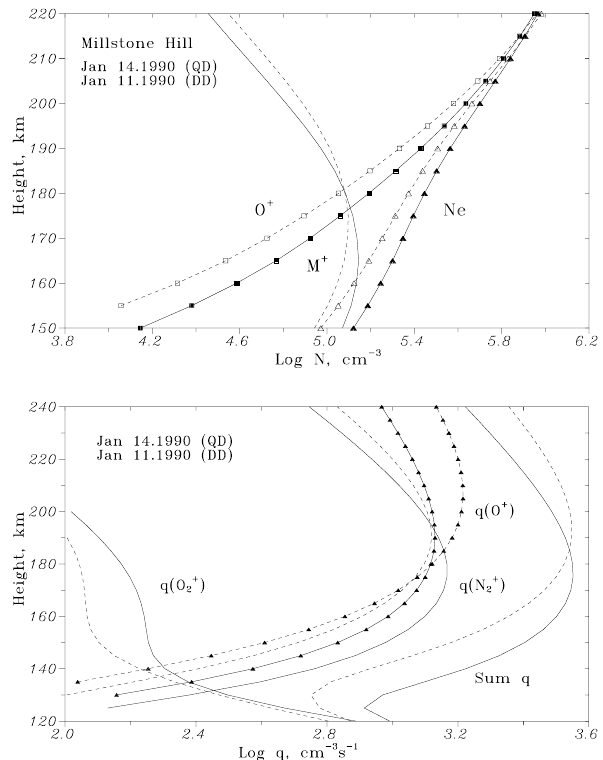
Fig. 8. Same as Fig. 3, but for a positive disturbance on 11 Jan/14 Jan 1990 with a height decreasing storm effect (top) and calculated ion production rates for this case